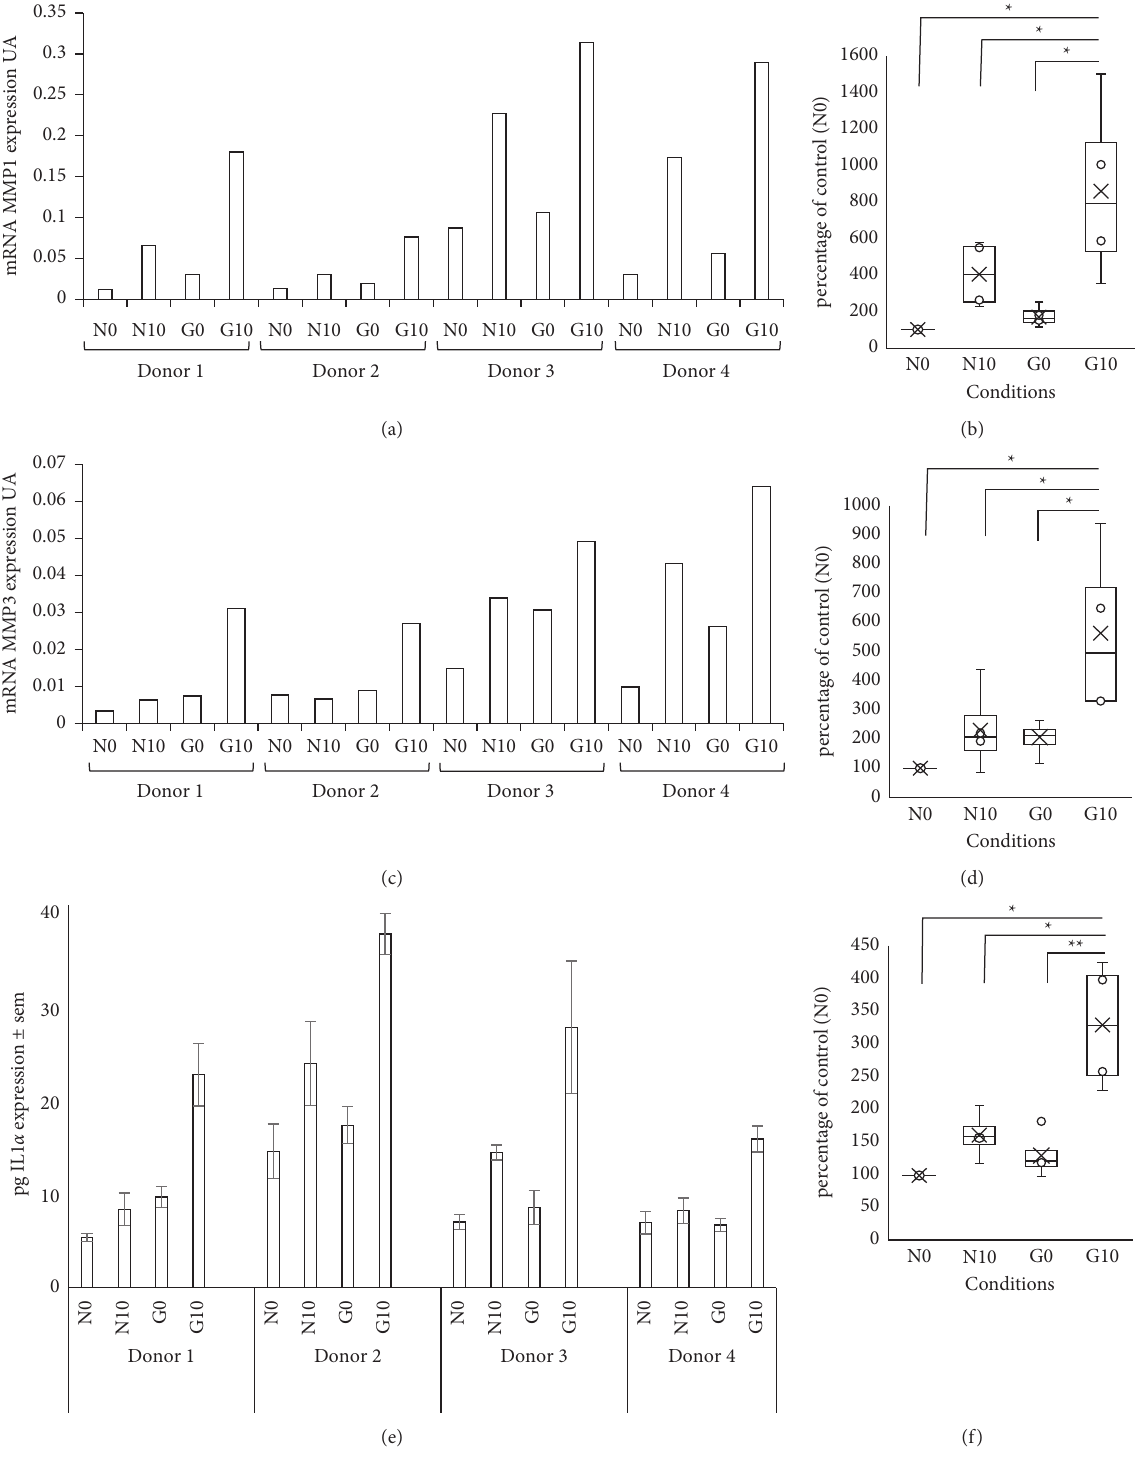
Figure 2: AGEs and UVA irradiation promote an environment for extracellular matrix degradation and inflammation. mRNA MMP1 (a, b) and mRNA MMP3 (c, d) expression measured in dermal layers and interleukin 1 alpha (IL1 α ) detection in the medium (e, f) of reconstructed skin made with fibroblasts isolated from 4 donors separately (a, c, e) or in box plots considering all donors in the same condition group, percentage of control N0 is reported (b, d, f). mRNA levels were quantified from dermal fibroblasts using quantitative reverse transcriptase- polymerase chain reaction (qPCR) 6 hours after UVA irradiation. Each point represents the mean value of normalized mRNA quantity ( n � 3). Data are expressed in arbitrary units (UA). IL1 α detection was quantified by the ELISA assay in the medium of reconstructed skin 48 hours after UVA irradiation (in pg IL1 α per 200 µ l of medium) (mean n � 3/donors) ± SEM). N0: native collagen without irradiation; N10: native collagen with irradiation (UVA 10J/cm 2 ); G0: glycated collagen without irradiation; and G10: glycated collagen with irradiation (UVA 10J/cm 2 ). Statistics: analysis of variance (ANOVA) adjusted post hoc Tukey–Kramer tests for pairwise comparisons ( ∗ P < 0.05; ∗∗ P <